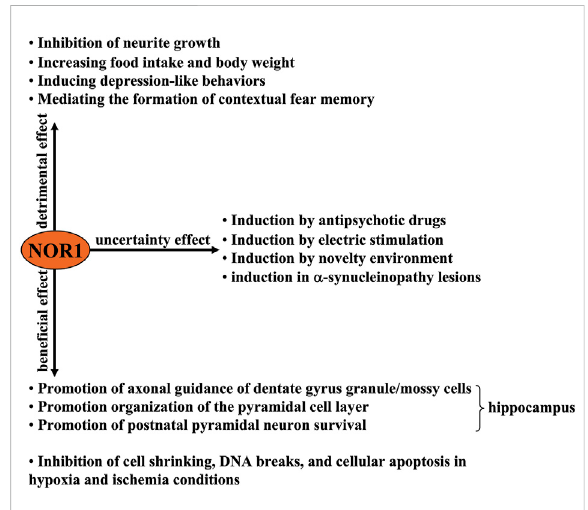
FIGURE 1 A schematic representation of the bene fi cial, harmful, and uncertaineffectsofNOR1inthenervoussystem. Bene fi cialeffects of NOR1 include inhibition of cell shrinkage, DNA breaks, and cellular apoptosis under hypoxia and ischemia conditions, as well as promotion of axonal guidance of dentate gyrus granule/ mossycells,organizationofthepyramidalcelllayer,andsurvivalof postnatal pyramidal neurons. The deleterious effects of NOR1includeinhibitingneuritegrowth,increasingfoodintakeand body weight, inducing depression-like behaviors, and mediating the formation of a contextual fear memory. The functional signi fi cance of its induction by antipsychotic drugs, electrical stimulation, novelty environment, and α -synucleinopathy lesions remains